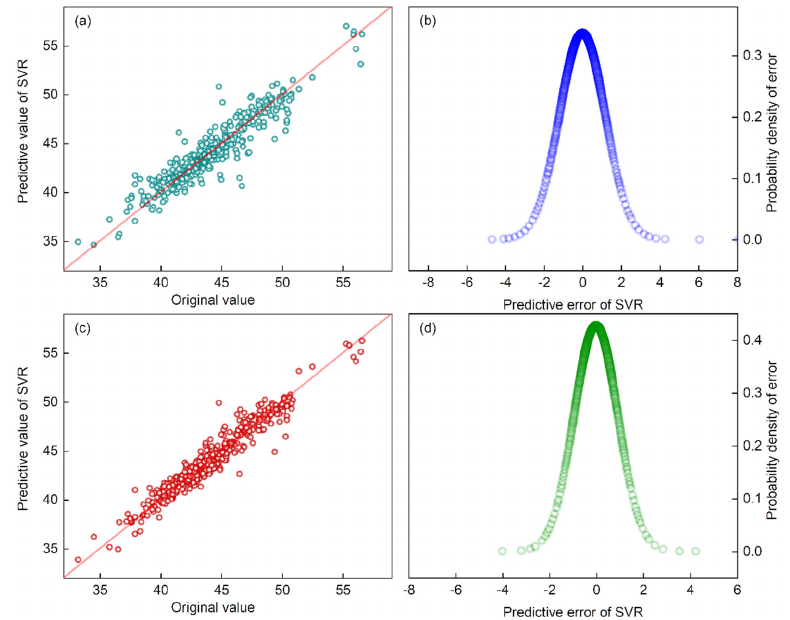
Figure 6. The prediction result of the SVR model based on BDS ( a ) and NDS ( b ) (the forecasting parameter is the GUR-1h). Figure 6a,b show the comparison among the original values and the predicted values of the SVR model based on BDS and NDS when the predicted parameter is GUR-1h, respectively. Figure 6 shows that the black points basically coincide with the red points and blue points, which indicates that the predicted values of the SVR model based on BDS and NDS are not of much difference from the true values. In the process of testing, the 8800 sets of data, which are 25% of the total sample, are selected as the test data. After sorting according to the actual values, the forecasting bias of the SVR model is as shown in Figure 7.